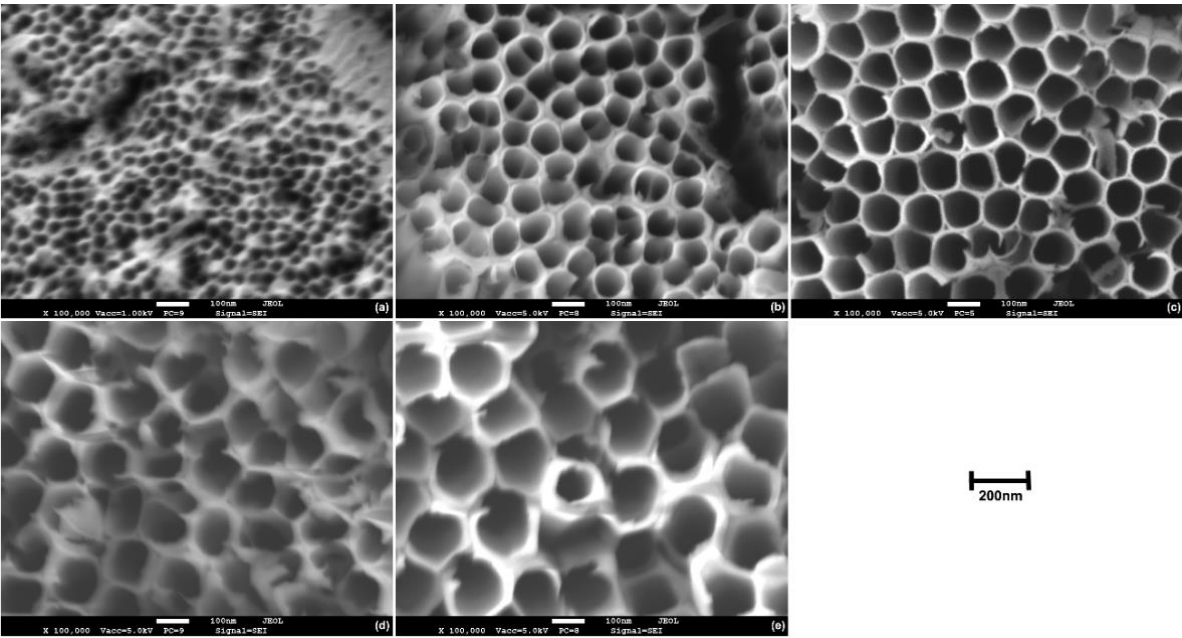
Figure 4. High magnification FESEM micrographs depicting a top-view of the anodic oxide layer produced over the α -phase through electrochemical anodization for 60 min at ( a ) 20 V, ( b ) 40 V, ( c ) 60 V, ( d ) 80 V, and ( e ) 100 V.